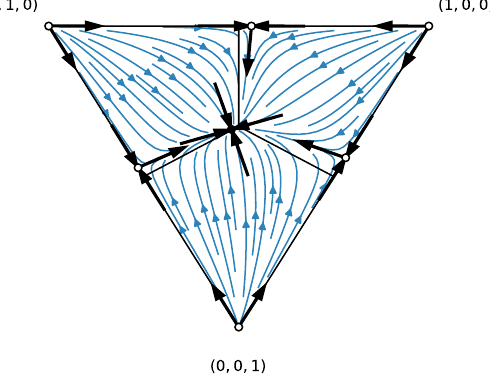
Figure 4. Coexistence of three aggressive strategies. Depicted is the flow diagram of the voter dynamics given p 1 = 0.3, p 2 = 0.2 and p 3 = 0.1. As obtained through our analysis of the two competitor dynamics, aggressive strategies promote coexistence. This is generalized in the three competitor cases, where an interior stable fixed point can exist when p i < 1/2 for all i .